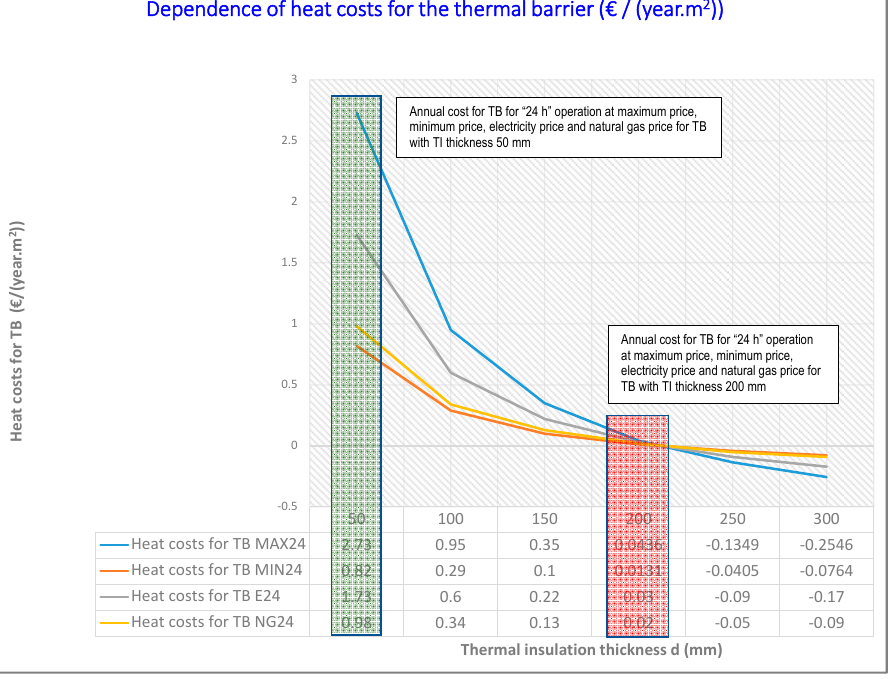
Figure 11. Dependence of heat demand for thermal barrier. Dependence of heat costs for the thermal barrier (€ / (year.m 2 ))